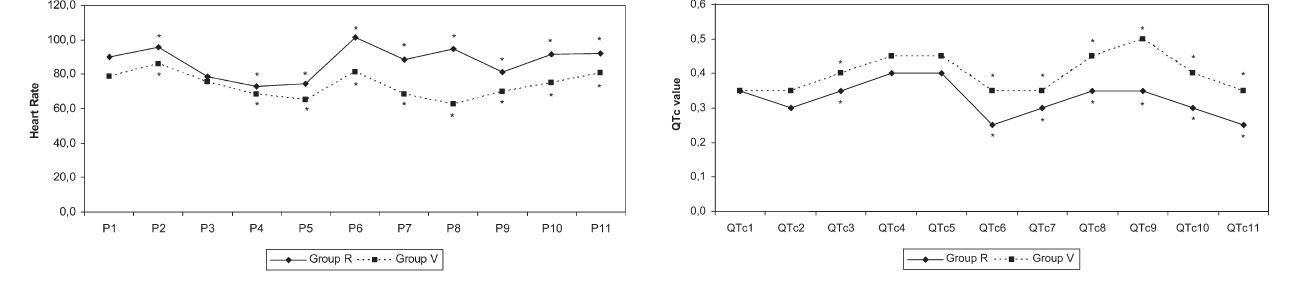
Figure 4 - QTd values in the two study groups